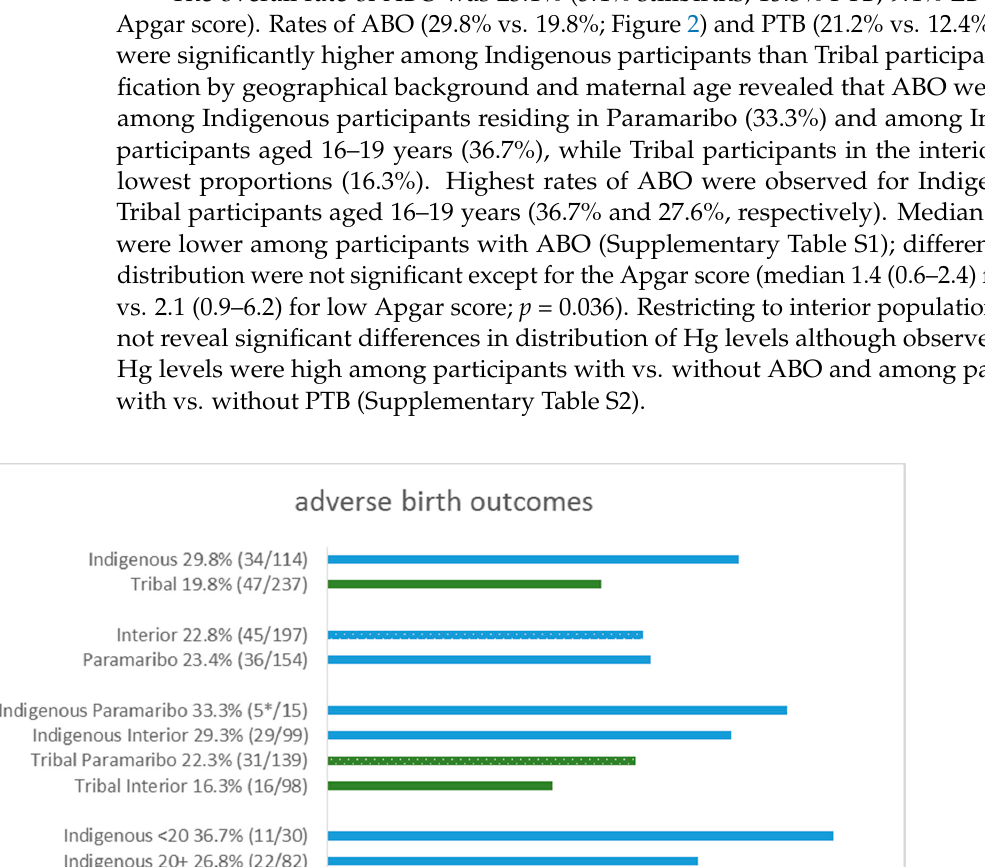
Figure 3. Rates of preterm birth stratified for ethnic background, geographical background, and age at delivery. * Rates are based on fewer than 10 PTB. Two-sample test for differences in proportions: Indigenous vs. Tribal ( p = 0.025); Interior vs. Paramaribo ( p = 0.763); Indigenous Interior vs. Indigenous Paramaribo ( p = 0.734); Tribal Interior vs. Tribal Paramaribo ( p = 0.316); Indigenous 16–19 years vs. Indigenous 20+ years ( p = 0.035); Tribal 16–19 years vs. Tribal 20+ years ( p = 0.377). Multivariate logistic regression analysis (Table 4) revealed that Indigenous partici- pants had higher odds of ABO compared with Tribal participants (adjusted OR = 3.6; 95% CI 1.70–7.63; p = 0.001) and lower odds of ABO for increased Hg exposure during preg- nancy (OR = 0.88; 95% CI 0.80–0.97; p = 0.011). Indigenous participants had higher odds of PTB compared with Tribal participants (adjusted OR = 3.4; 95% CI 1.48–7.96; p = 0.004) and lower odds of PTB for increased Hg exposure (OR = 0.88; 95% CI 0.88–0.99; p = 0.027), as well as for maternal age at delivery (Table 4). Excluding ethnic background Indigenous